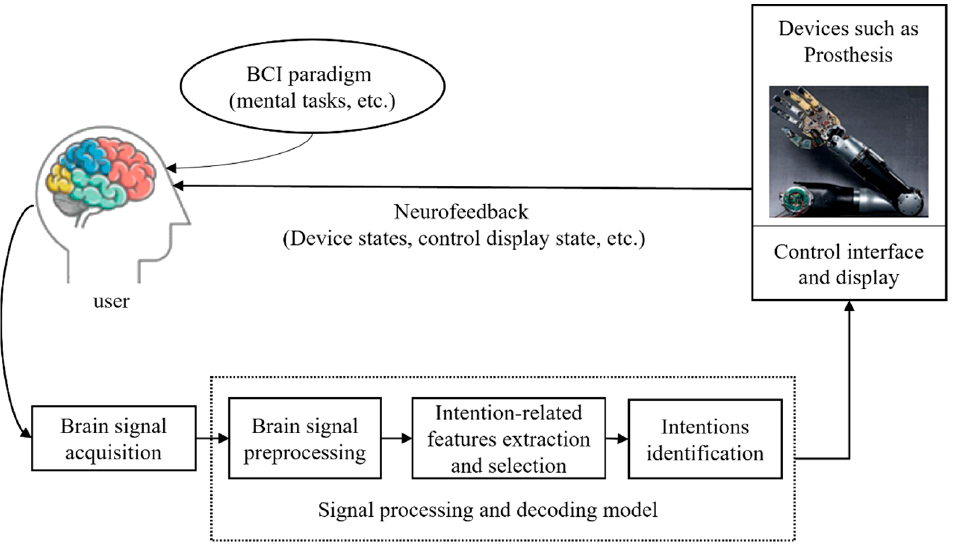
Figure 1. Schematic diagram of a general BCI system.